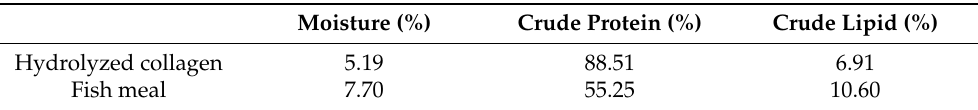
Table 2. Comparison of proximate composition between hydrolyzed collagen and fish meal (% wet